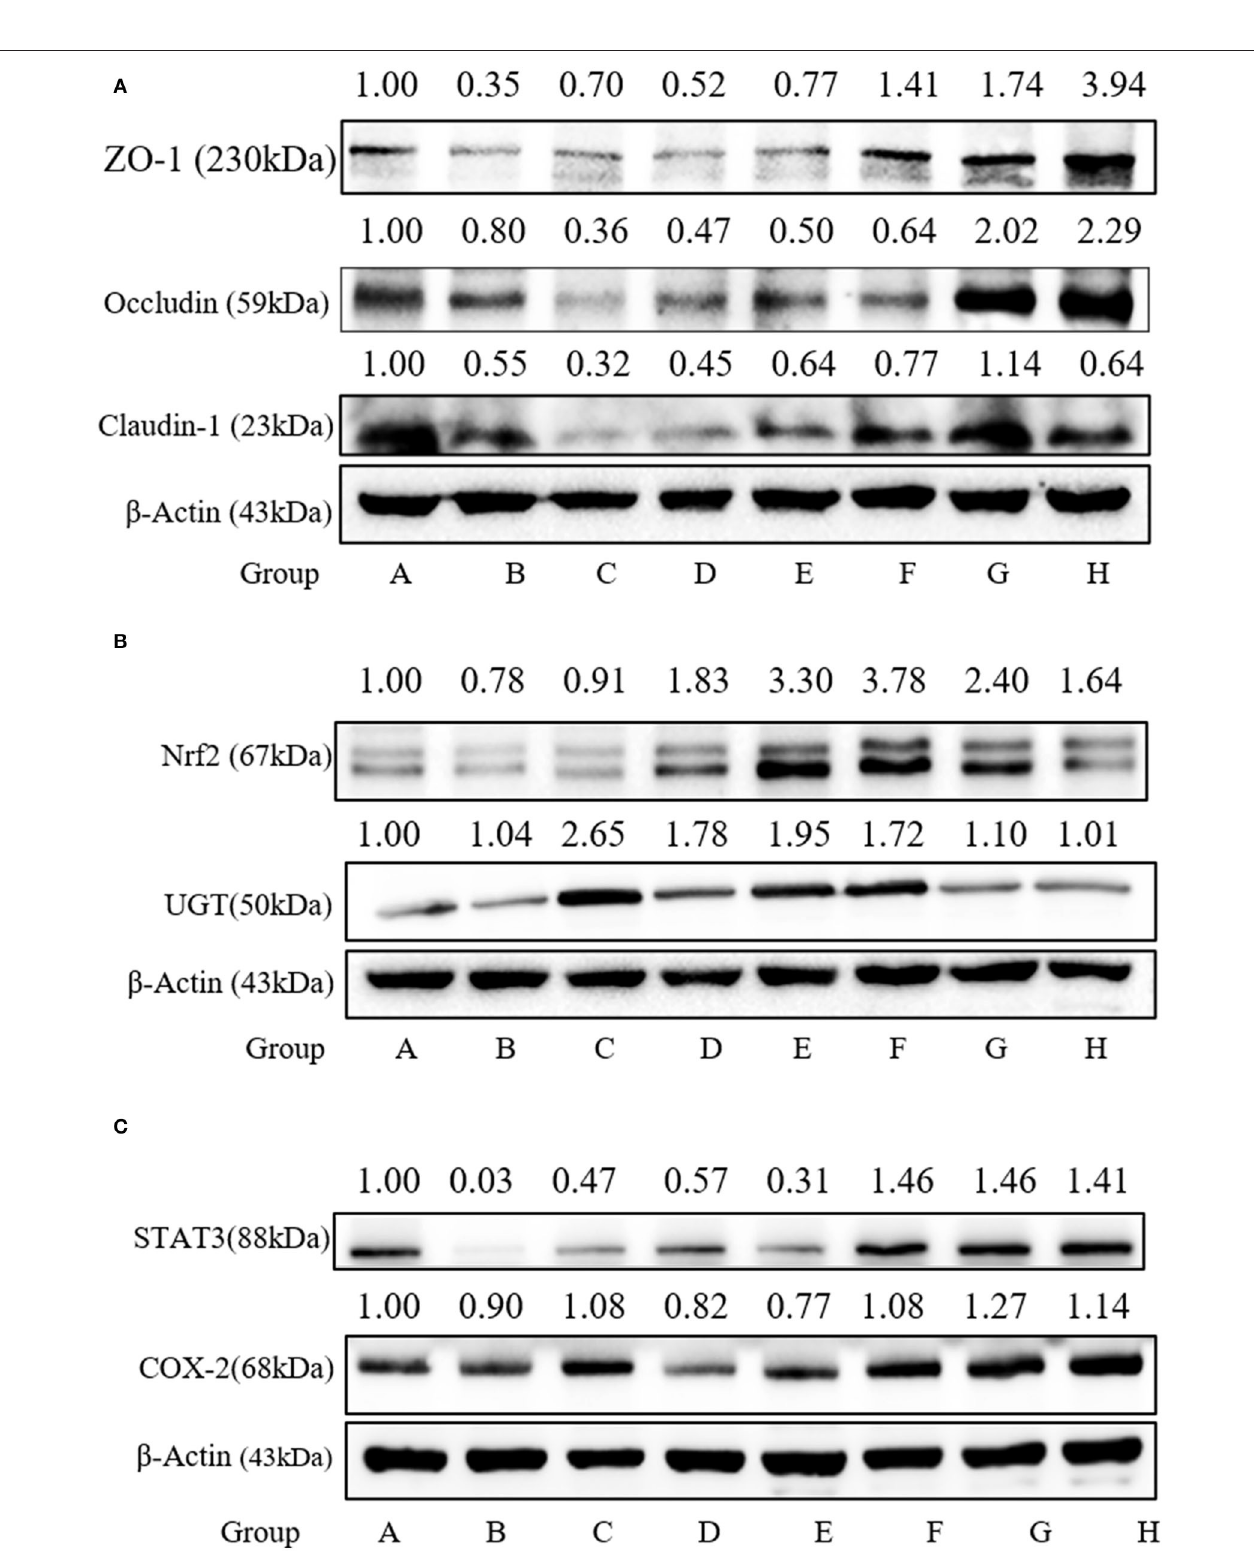
FIGURE 8 | Effect of SFN on tight junction and Nrf2-related protein expression in colitis mice. (A) Relative expression of ZO-1, Occludin, and Claudin-1 in colon tissues as measured by Western blotting. (B) Relative expression of Nrf2 and UGT in colon tissues as measured by Western blotting. (C) Relative expression of STAT3 and COX-2 in colon tissues as measured by Western blotting. All data are presented as the mean ± SD.